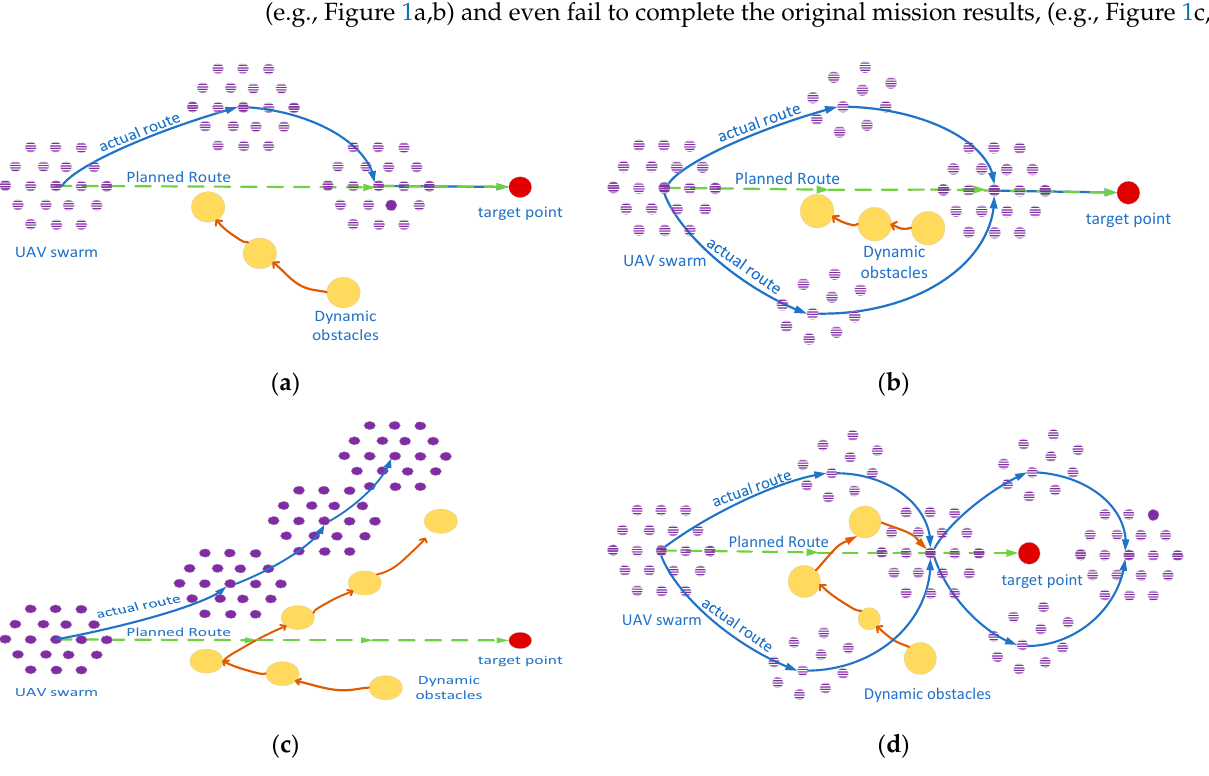
Figure 1. The effect of dynamic obstacles on traditional swarm motion. ( a ) swarm reaches the target point in a roundabout manner avoiding dynamic obstacles; ( b ) swarm reaches the target point by avoiding dynamic obstacles without tracking capabilities in fission–fusion; ( c ) swarm avoids dynamic obstacles with tracking capabilities in a roundabout manner but cannot reach the target point; ( d ) swarm evades dynamic obstacles with tracking capabilities in a fission–fusion but cannot reach the target point.